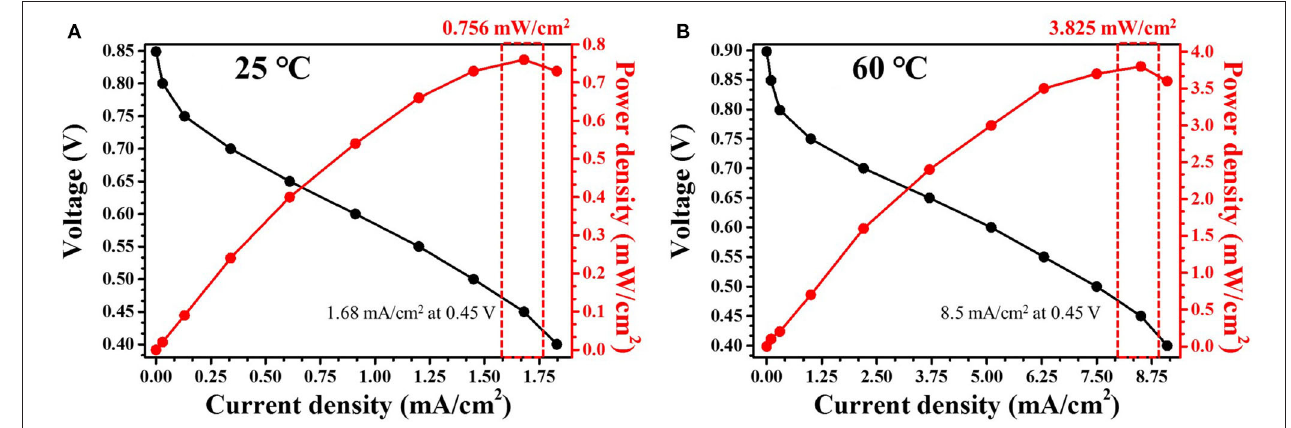
FIGURE 11 | I-V curves obtained using Ni-Pd(P)/MWCNT catalyst in a 5 cm 2 unit cell at (A) 25 ◦ C and (B) 60 ◦ C in 3.0M KOH/1.0M urea